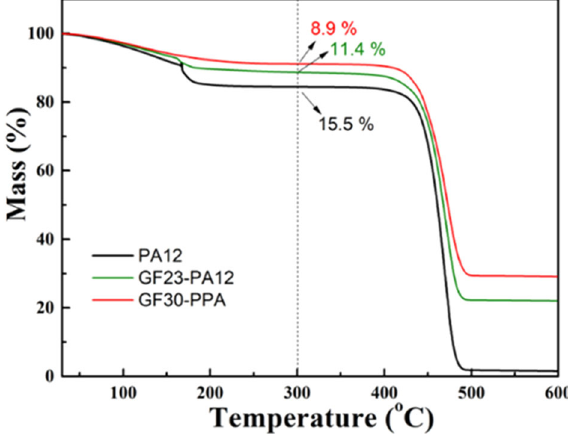
Fig. 2 TG curves of the PA12, GF23-PA12 and GF30-PPA samples aged for 150 h in E25 in